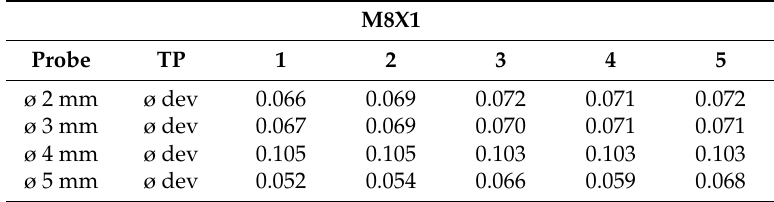
Table 4. TP of the thread, found by measuring using 4 probes and 5